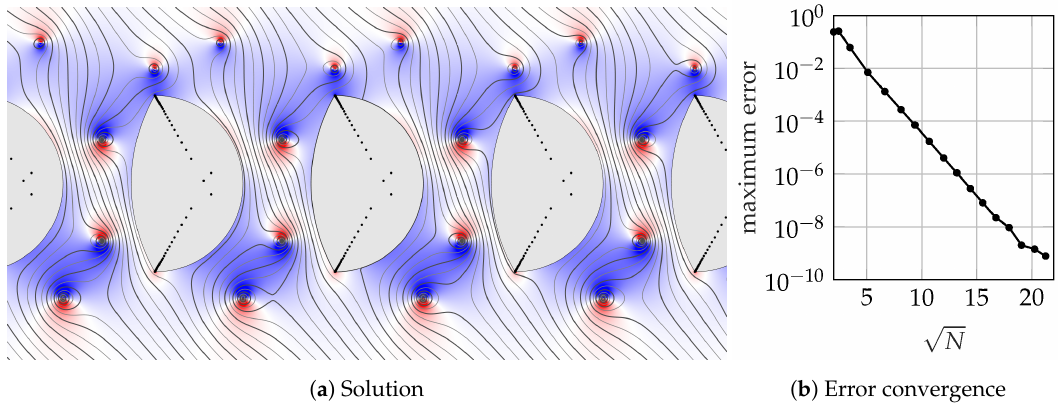
Figure 4. Uniform flow past a periodic array of boundaries with embedded point vortices. The black dots represent the prescribed poles of the rational function. The solution converges to 9 digits of accuracy in 0.8